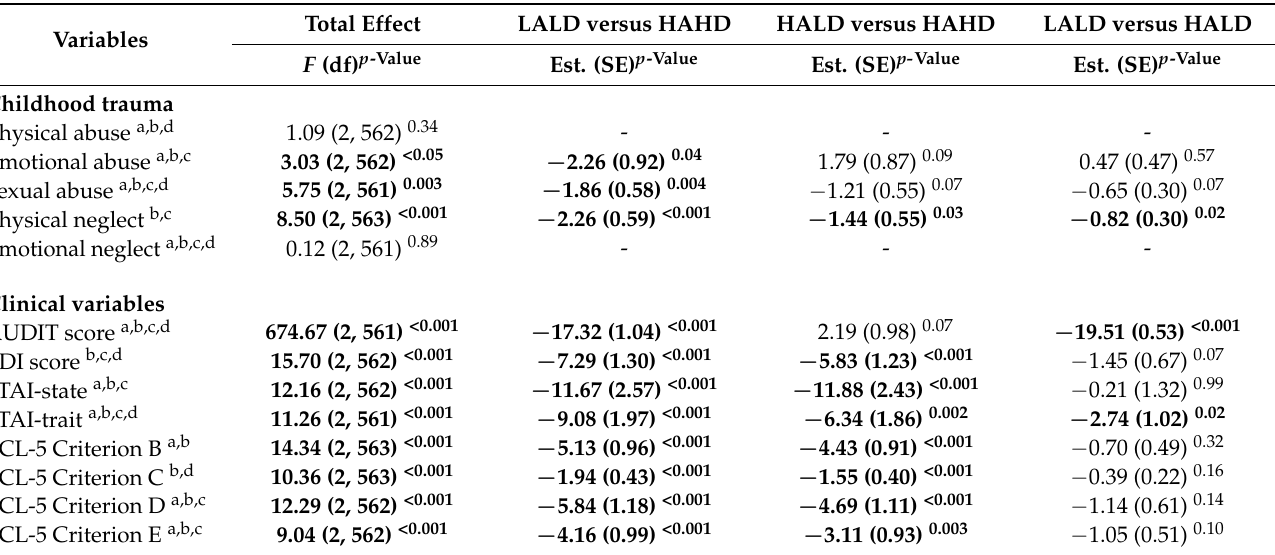
Table 2. Childhood trauma and clinical variables by cluster (adjusted